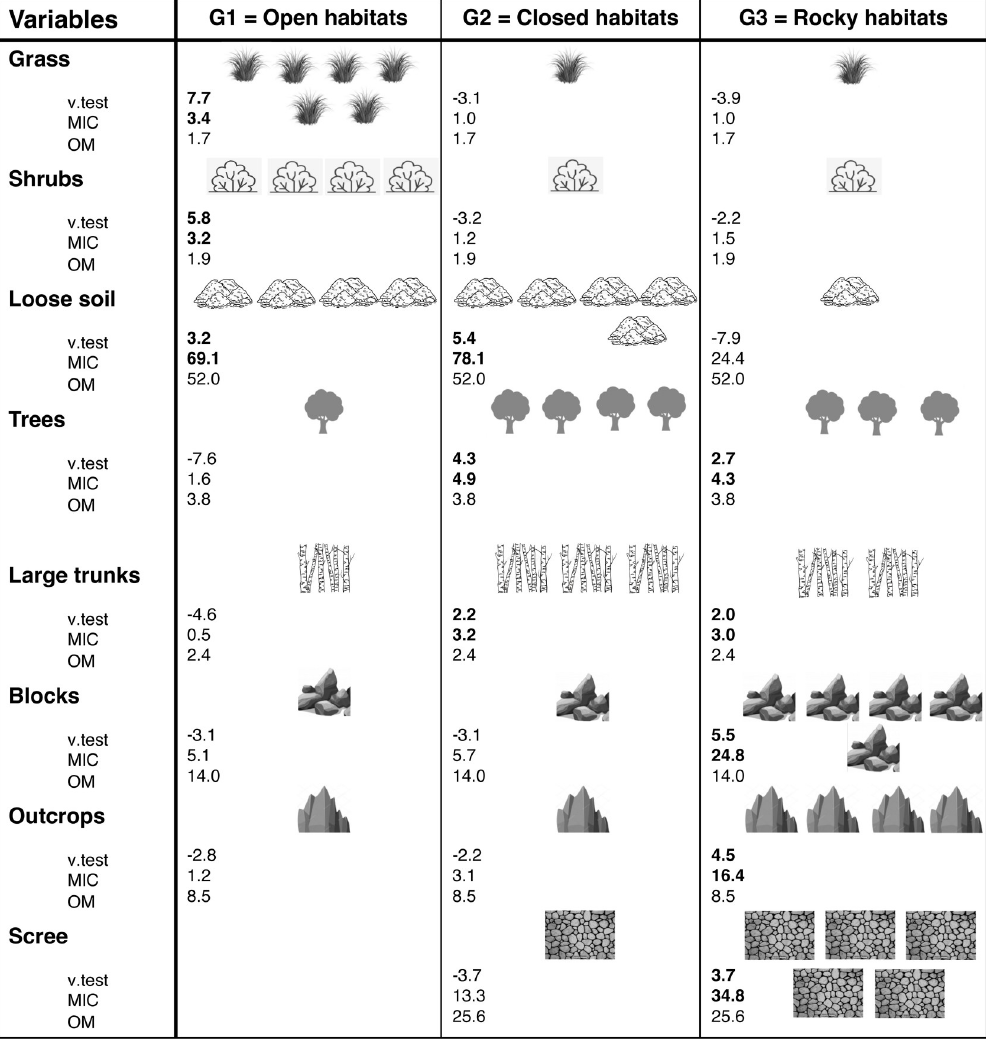
mainly composed of grass, shrubs and loose soil; Group 2 (G2): habitat mainly composed of loose soil, trees and large trunks; Group 3 (G3): habitat mainly composed of blocks, outcrops, scree and trees with large